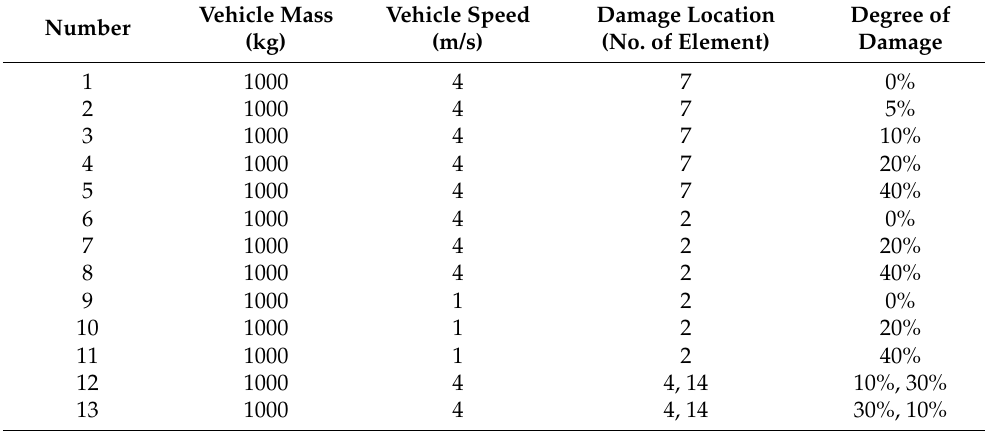
Table 2. Case setting for VBI analysis.